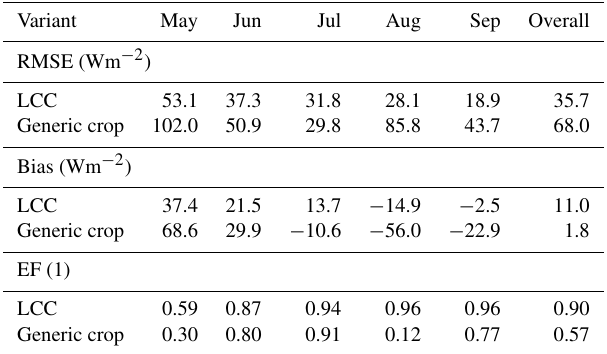
Table 6. Root-mean-square error (RMSE), bias and modeling effi- ciency (EF) of the latent heat flux for the simulation runs of maize stand (EC2